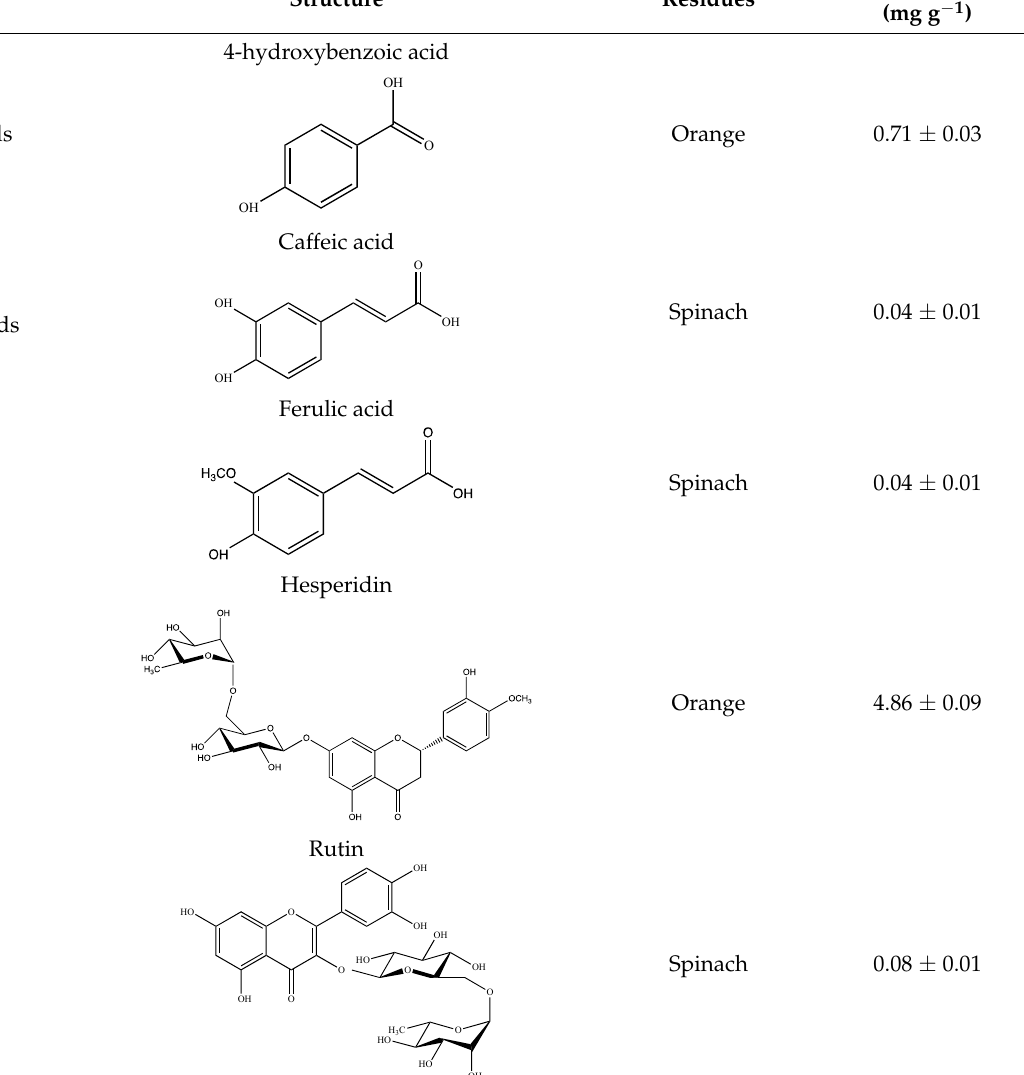
Table 4. Identified phenolic compounds in the extracts from orange and spinach matrices, their respective family, structure, and concentration under optima conditions.